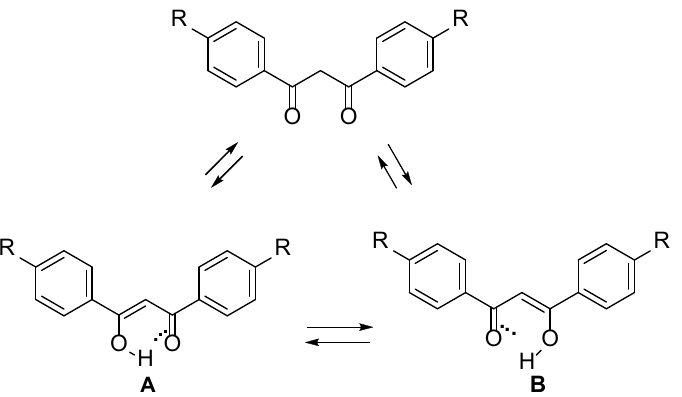
Figure 1. Graphical scheme of studied compounds DBM (R = H), DBM-OMe (R = OCH 3 ), and DBM-NO 2 (R = NO 2 ). ( A , B ) are two symmetrical positions of the proton on an intramolecular hydrogen bond.